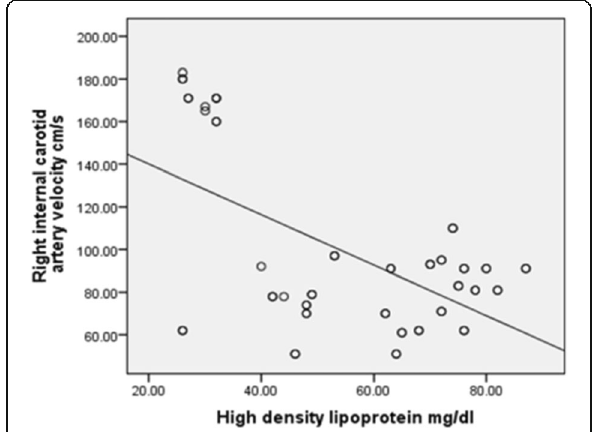
Fig. 1 Negative correlation between high-density lipoprotein (milligrams/deciliter) and right internal carotid artery velocity (centimeters/second)